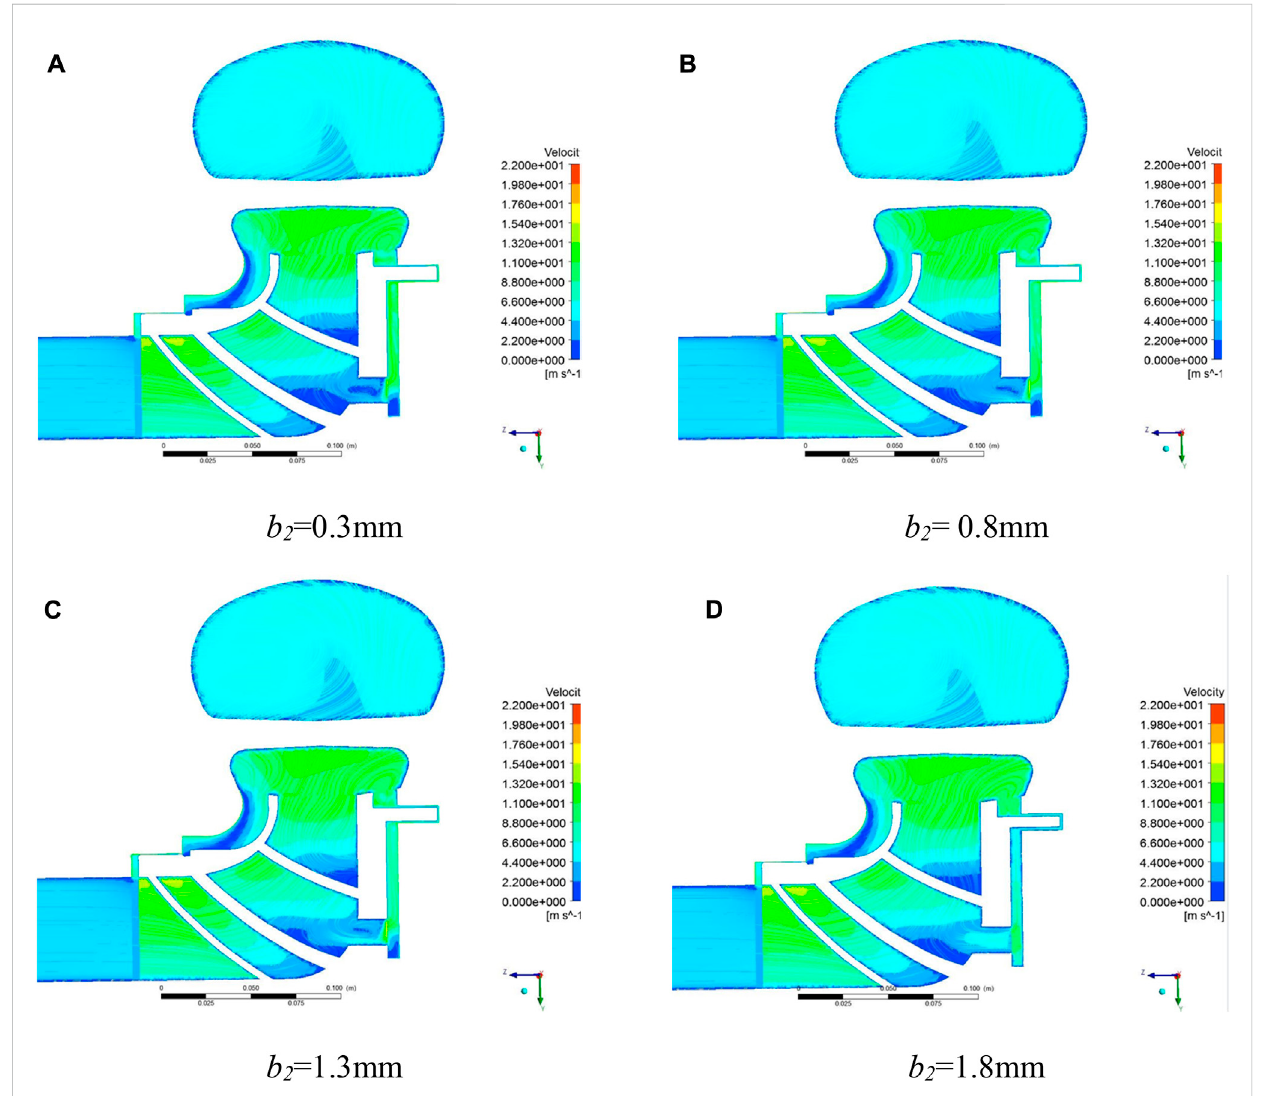
FIGURE 9 TheabsolutevelocitydistributionofX=0sectionunderdifferentclearanceofbackwear-ring. (A) b 2 =0.3 mm; (B) b 2 =0.8 mm; (C) b 2 =1.3 mm; (D) b 2 = 1.8